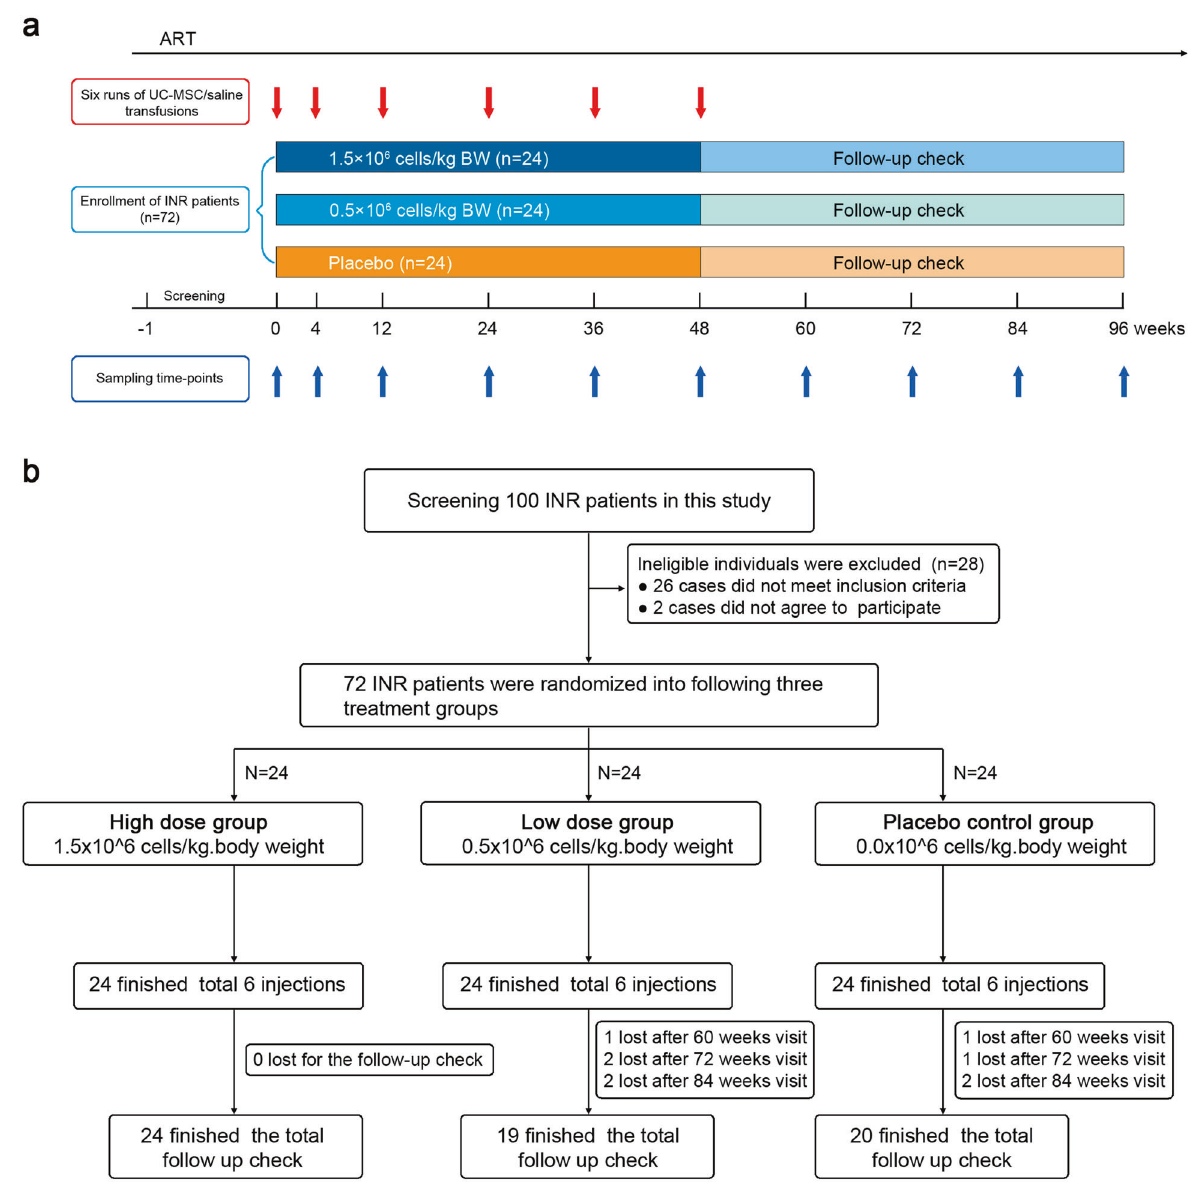
Fig. 1 Study design. a Graphic overview of the study schedule; and b CONSORT (Consolidated Standards of Reporting Trials)